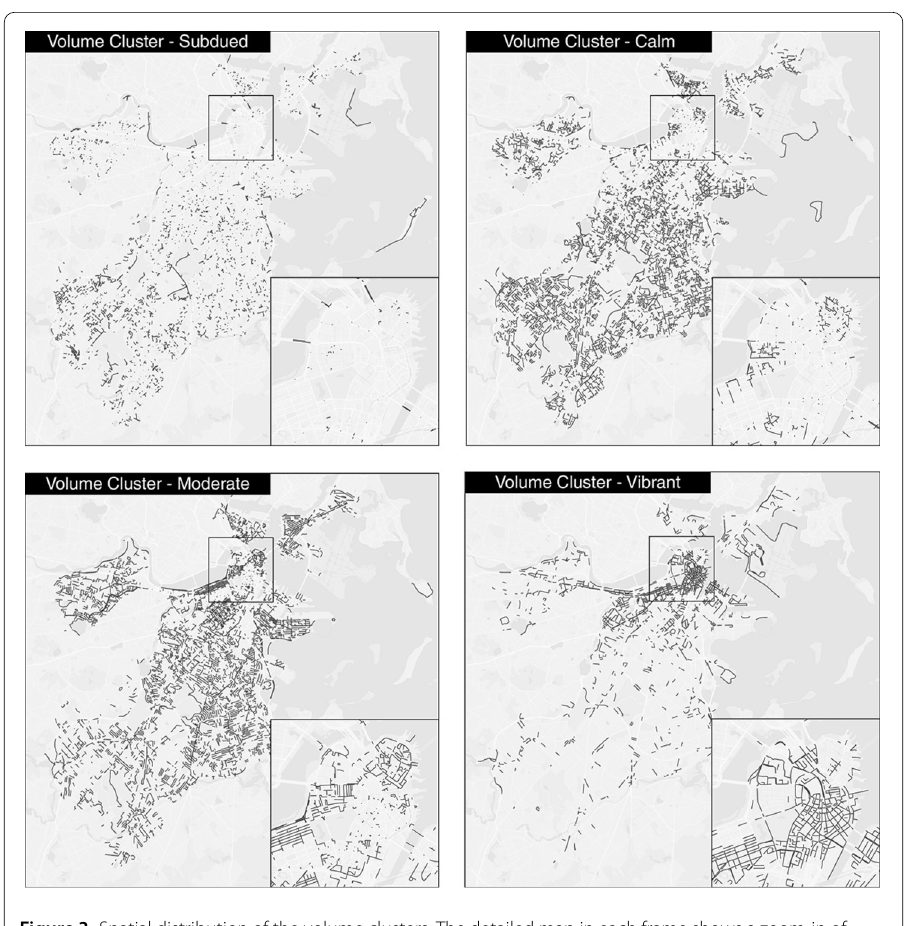
Figure 3 Spatial distribution of the volume clusters. The detailed map in each frame shows a zoom-in of Boston’s downtown area